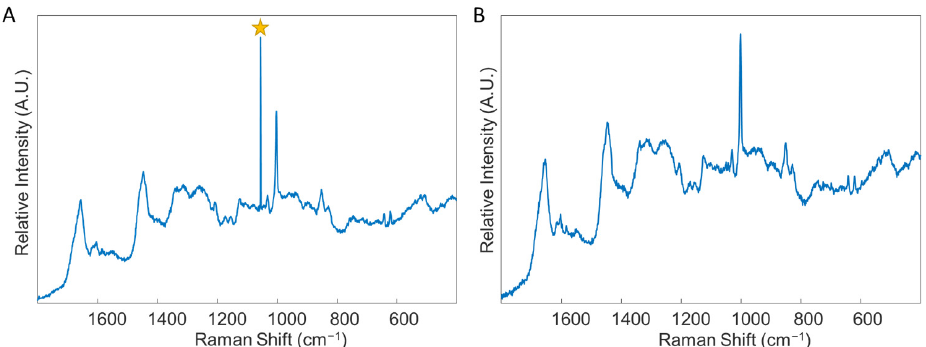
Figure 4. An example of a spectrum with a cosmic ray, denoted by the star ( A ), and an example of a spectrum without any cosmic rays ( B ). Both spectra were obtained through analysis of blood serum. Star: denotes cosmic ray.